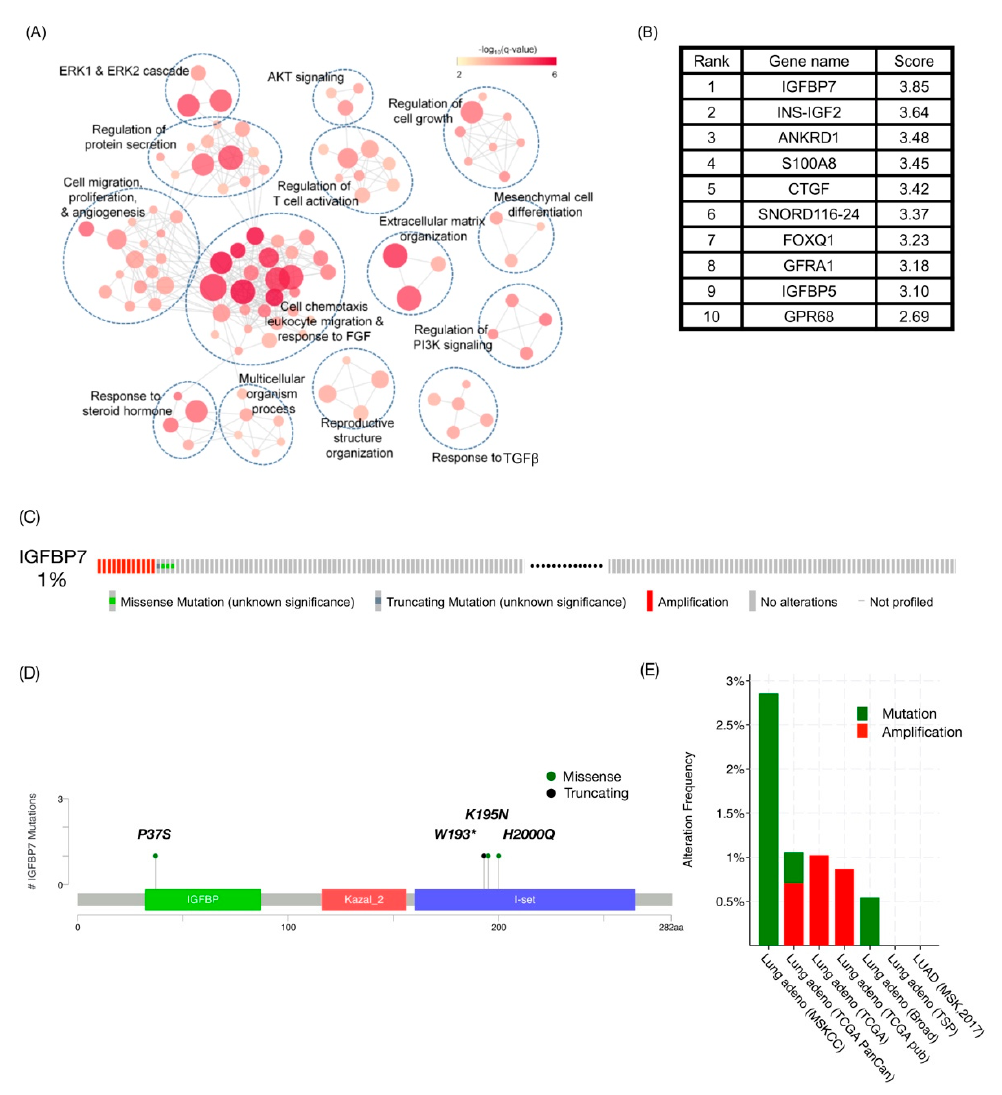
resistance-related gene (Figure 1B). Integrative analysis revealed the impact of IGFBP7 expression on TKI-resistance.